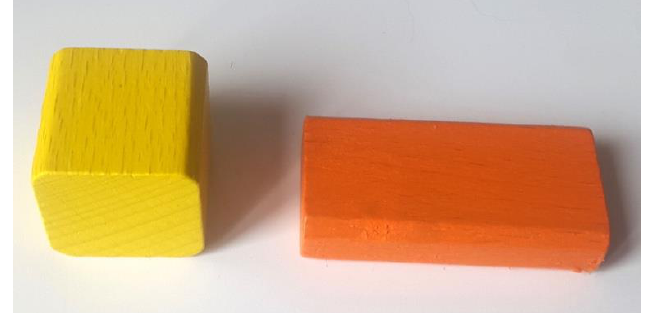
Figure 6. The two object types used in Experiment